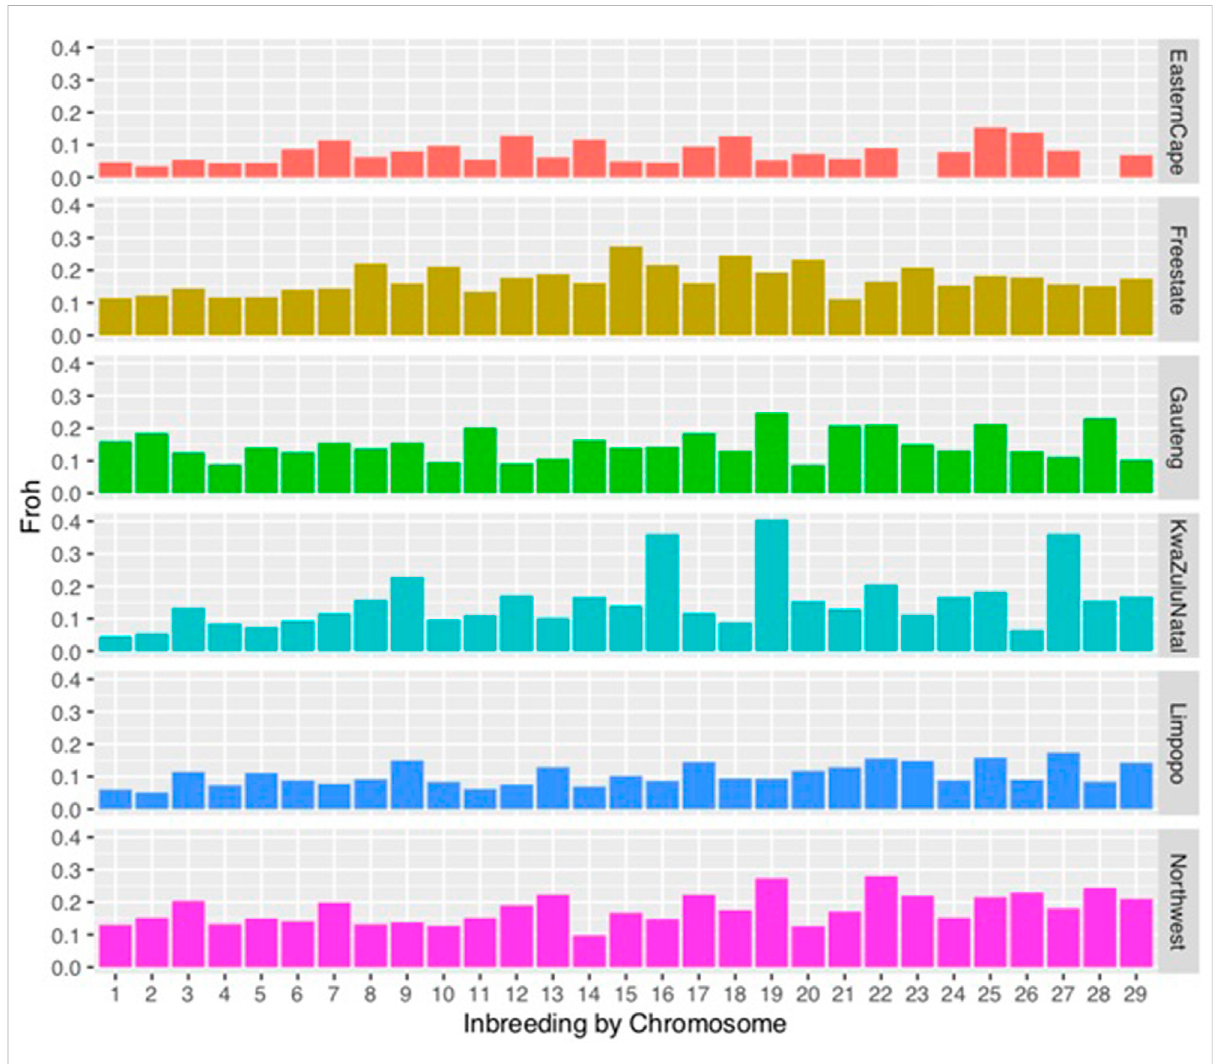
FIGURE 3 Distribution of inbreeding coef fi cients (FROH) based on runs of homozygosity (ROH) for each